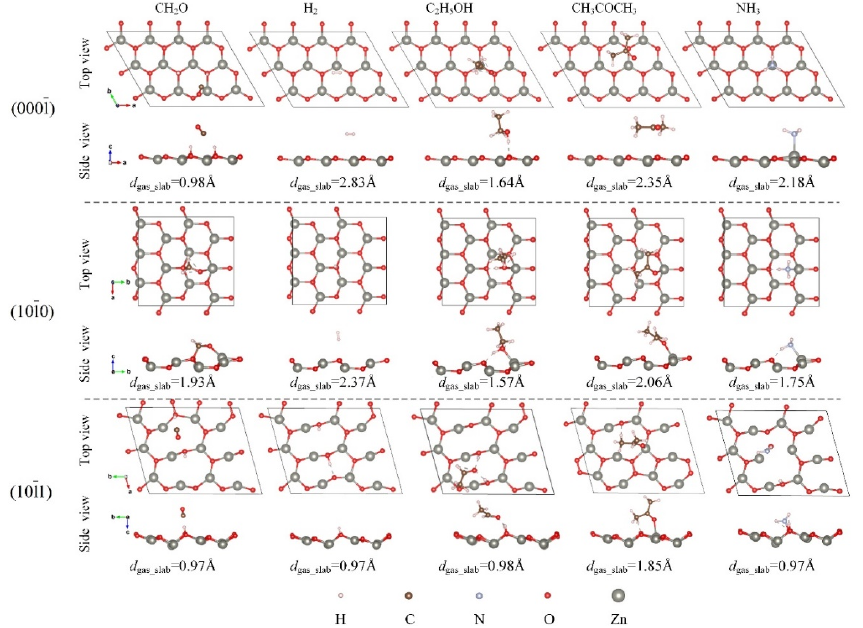
Figure 2. The optimized gas adsorption conformations on ZnO(0001) , ZnO(1010)